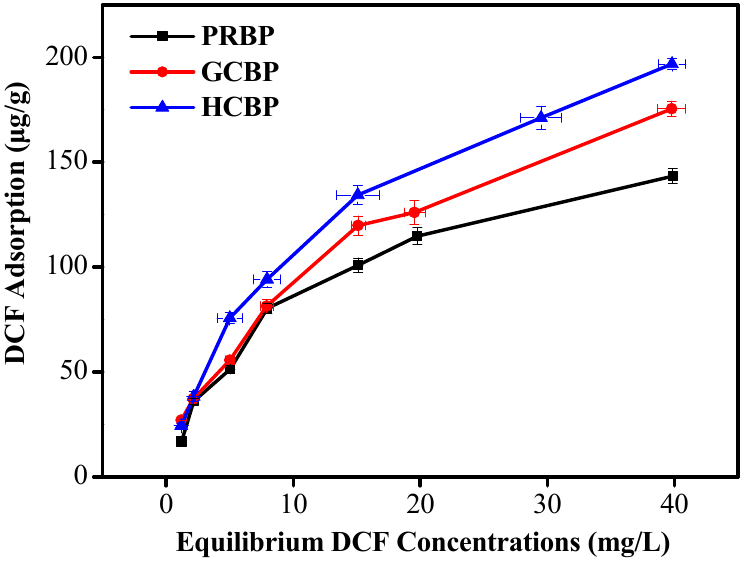
Figure 7. The adsorption isotherm of DCF onto PRBP, GCBP, and HCBP. Experimental conditions: m = 2 g/L, T = 25 ± 1 °C, pH = 7.0 ± 0.1.